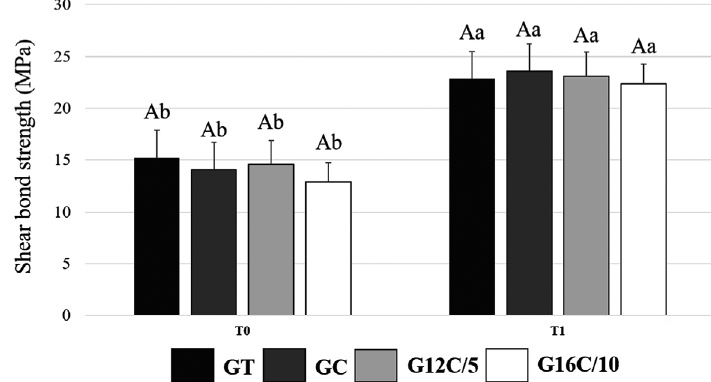
Figure 3- Results of shear bond strength (SBS) immediately (T0) and after six months (T1) of aging in distilled water. The values of SBS are expressed in mean and standard deviation of MPa. Same capital letters indicate no statistically significant differences among the materials within the same time (p>0.05). Different small letters indicate statistically significant difference for the same adhesive comparing the results of different times (p<0.05) Table 1- Mean and standard deviation values of degree of conversion (DC) and cell viability of the orthodontic adhesive Groups